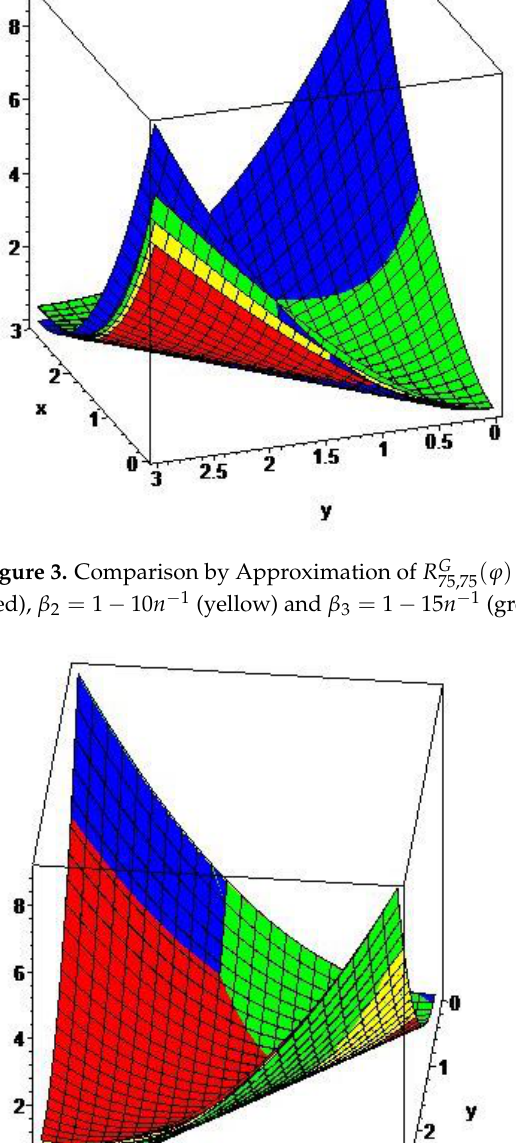
( ϕ ) to ϕ (blue) on [ 0,3 ] × [ 0,3 ] for β 75,75